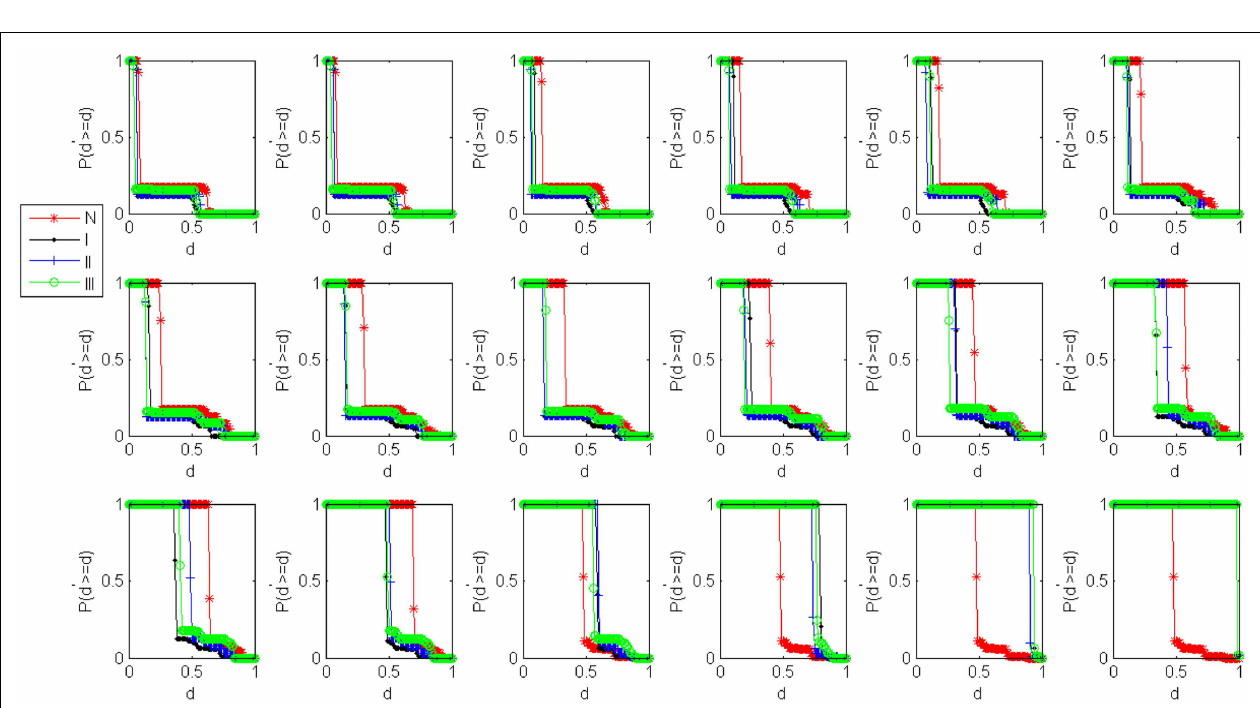
FIGURE 4 | Damage distributions for cascading events in renal cancer networks. Plots of the cumulative probability of size-ratio of cascading failure P ( d (cid:48) ≥ d ) versus the size of cascading failure of node d in 18 threshold values.The red, black, blue, and green curves correspond to the cases of the normal state, stage I, stage II, stage III